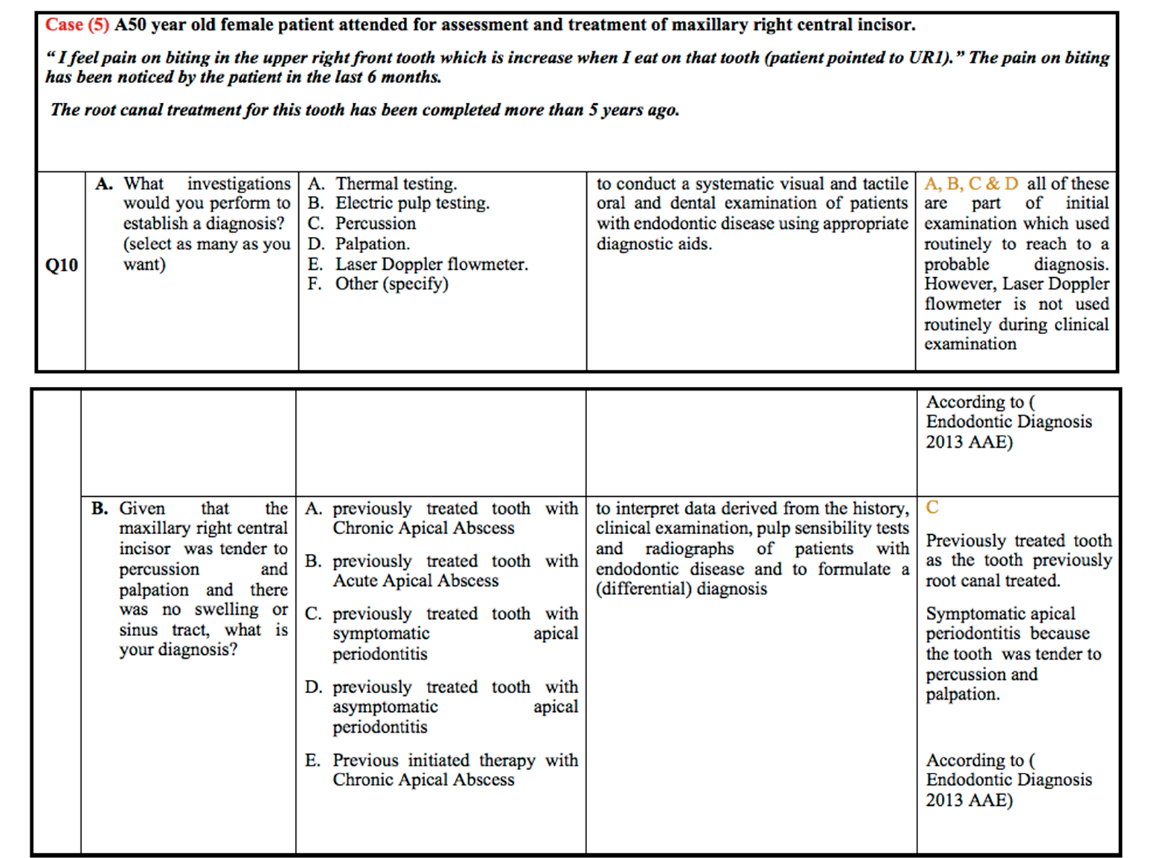
Figure 5. Clinical case scenario 5.